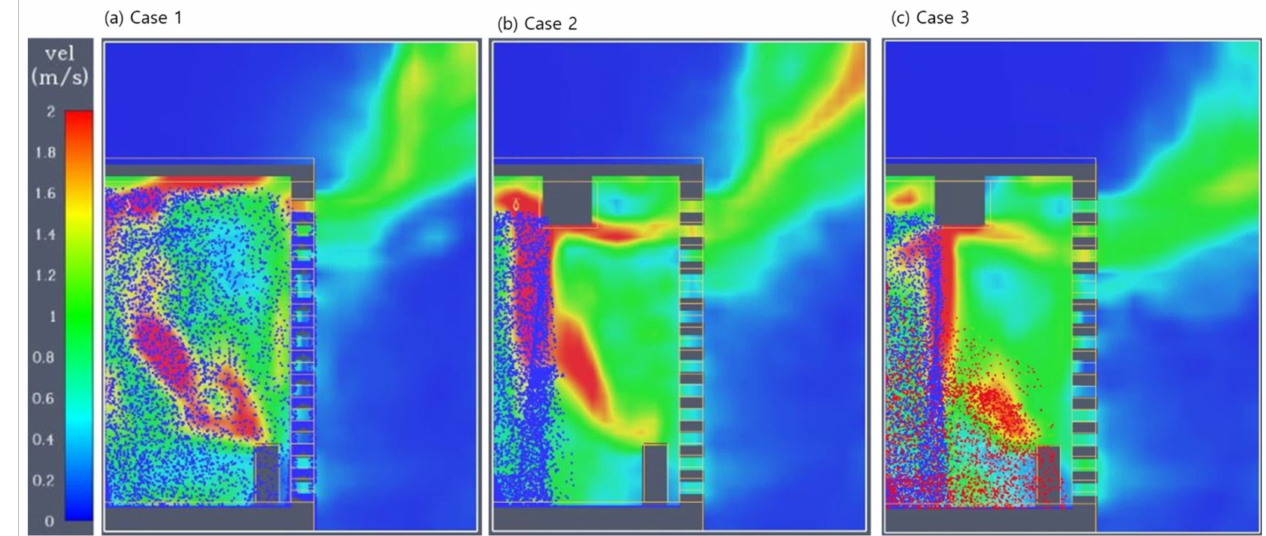
Figure 4. Velocity contour of XZ plan Y = 0, ( a ): Case 1, ( b ): Case 2, ( c ): Case